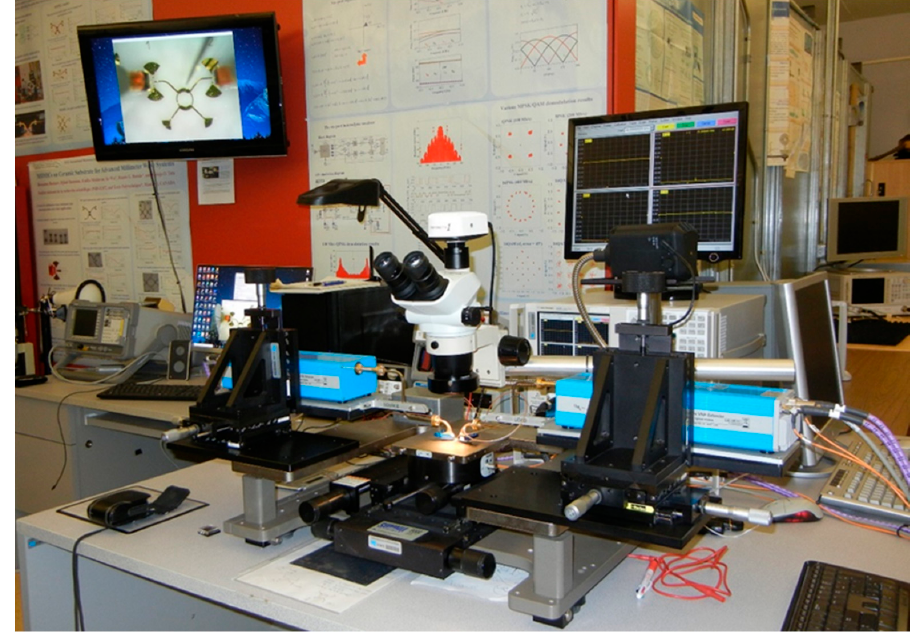
Figure 23. Measurement set-up: millimeter wave probe station and vector network analyzer (VNA). Details of the S-parameter measurements set-up, including a MHMIC die under test, are presented in Figures 24 and 25.